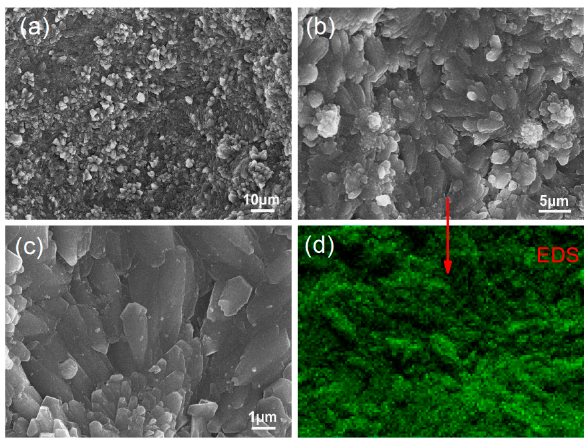
Figure 9. ( a – c ) SEM images of GO/PAH/cement composites with GO/PAH intercalation composites. ( d ) Carbon map of the area presented in ( b ).